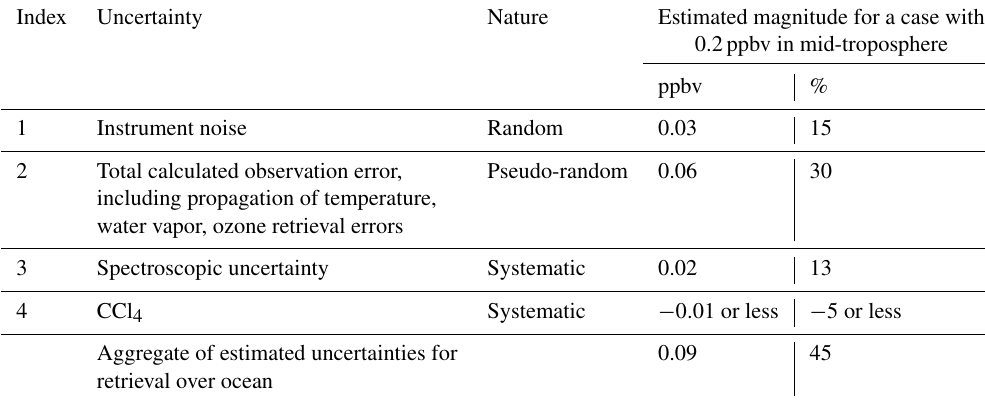
Table 2. Estimated contributions to the PAN retrieval error for a single CrIS